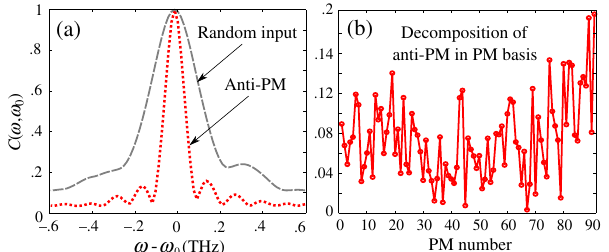
FIG. 5. Experimentally measured anti-PM in the same fiber as in Fig. 1. (a) The spectral correlation function of the narrowest anti-PM (red dotted line), which is notably narrower than that for a random input (gray dashed line). (b) Because of mode- dependent loss, the decomposition of this anti-PM in the PM basis does not give the bimodal distribution as in Fig. 4(b); instead, it gives a broad distribution over all available PMs. This result agrees with the numerical simulation that includes the MDL (see Ref.